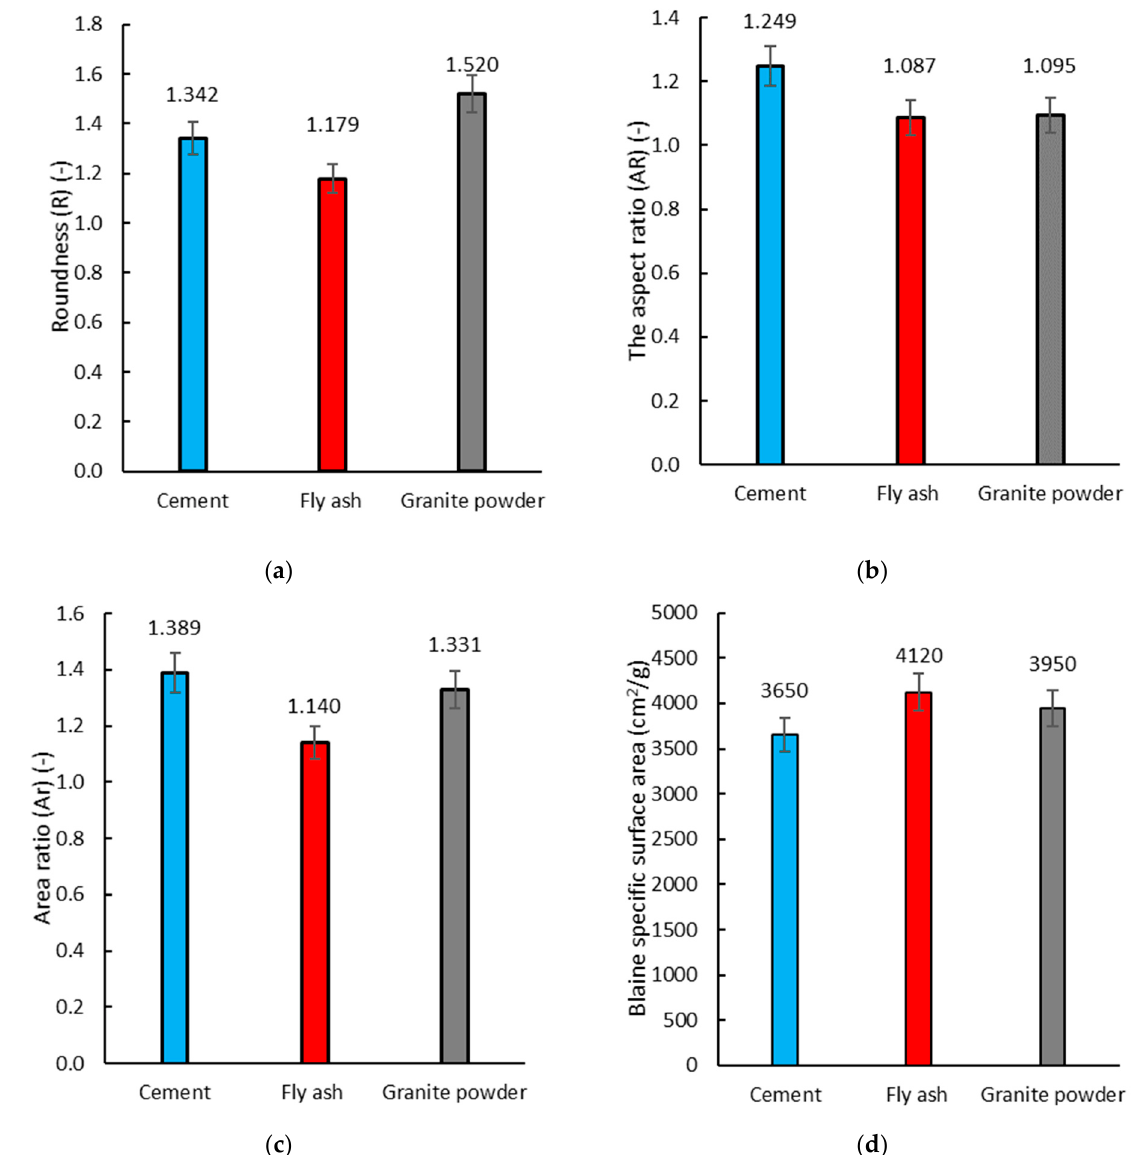
Figure 4. Scanning electron microscope (SEM) analysis of the binders: ( a ) cement CEM I 42.5, ( b ) siliceous fly ash, and ( c ) granite powder.